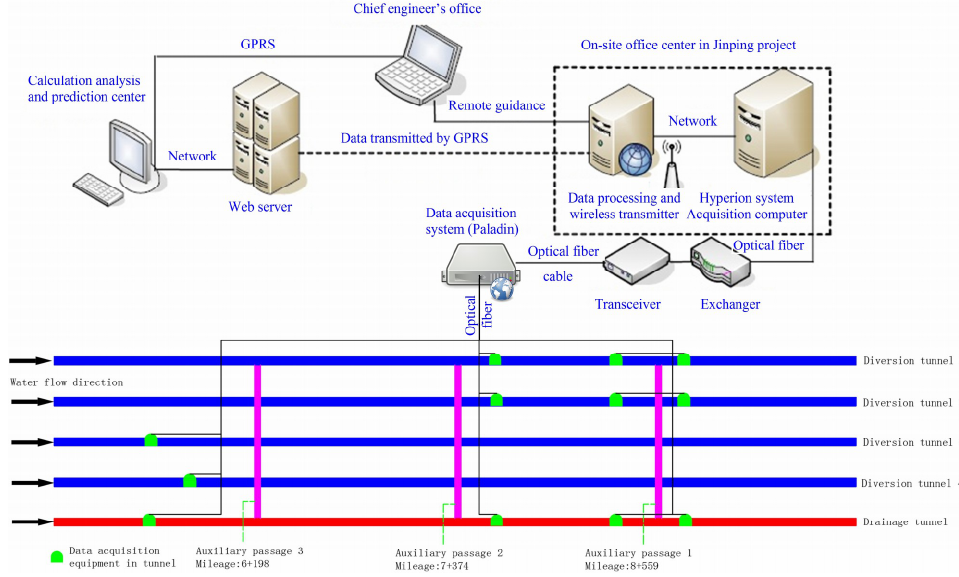
Figure 3. MS monitoring system of the Jinping II hydropower station